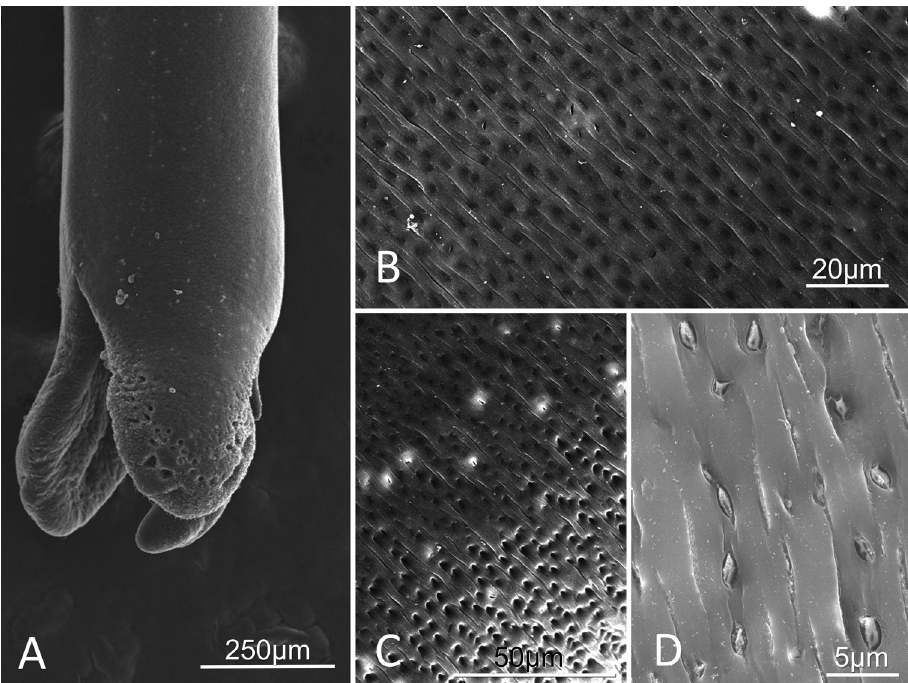
Figure 4. Paragordius amicus sp. n. adult female from the Santa Rita Mountains A Trifurcating posterior B–D Midbody cuticle surface of with transverse striations containing round to slightly oblong indentations B–C Areas with only hollow indentations D Area of cuticle with more oblong indentations housing